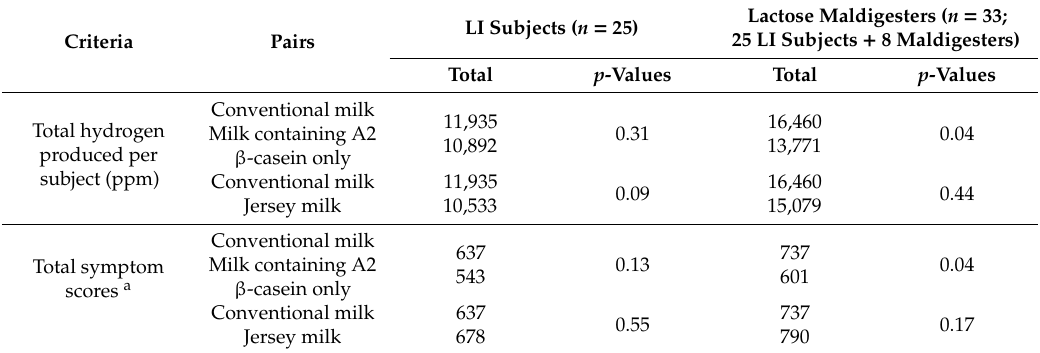
Table 3. Comparison of total hydrogen produced, and symptoms